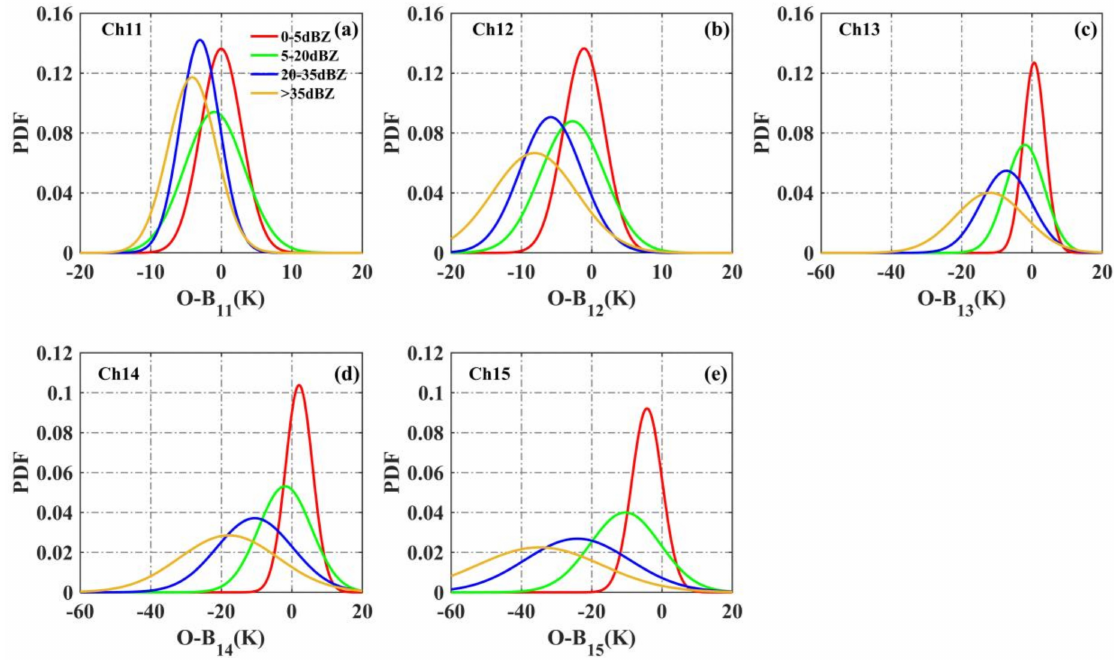
Figure 11. Probability density function of normalized O − B for channels 11–15 within the classification of 0–5 dBZ identified by precipitation-free (the red line), 5–20 dBZ identified by light precipitation (the green line), 20–35 dBZ identified by moderate precipitation (the blue line), and above 35 dBZ identified by intense precipitation (the orange line), with data sampled from July to September in